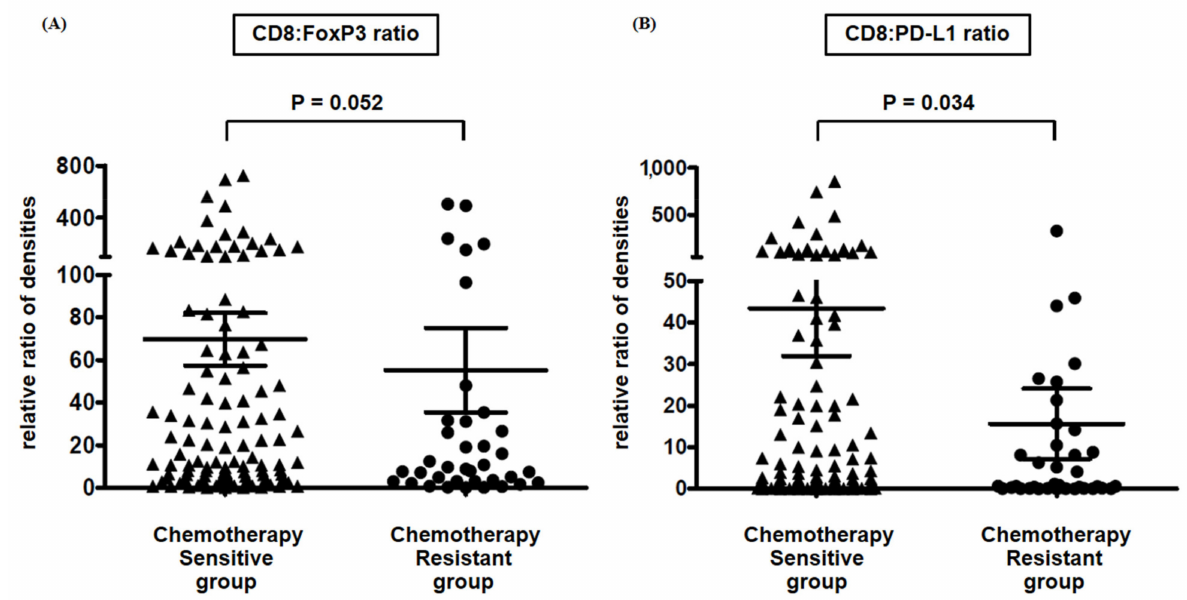
Figure 5. Platinum sensitivity according to ratios of CD8:FoxP3 and CD8:PD-L1. We classified patients according to their clinical response to frontline chemotherapy (paclitaxel/carboplatin) and analyzed CD8 to FoxP3 or PD-L1 expression ratio in two patient groups. ( A ) CD8:FoxP3 ratio seemed to be high in the chemotherapy-sensitive group; however, it was not significant ( p = 0.052). ( B ) CD8:PD-L1 ratio was significantly higher in the chemotherapy-sensitive group ( p = 0.034). ( ∆ , CD8:FoxP3 ratio and CD8:PD-L1 ratio in chemotherapy sensitive group, respectively; • , CD8:FoxP3 ratio and CD8:PD-L1 ratio in chemotherapy resistant group, respectively). Table 1. Multivariate analysis of prognostic factors associated with overall survival. Hazard Ratio 95% CI p -Value FIGO stage 1.784